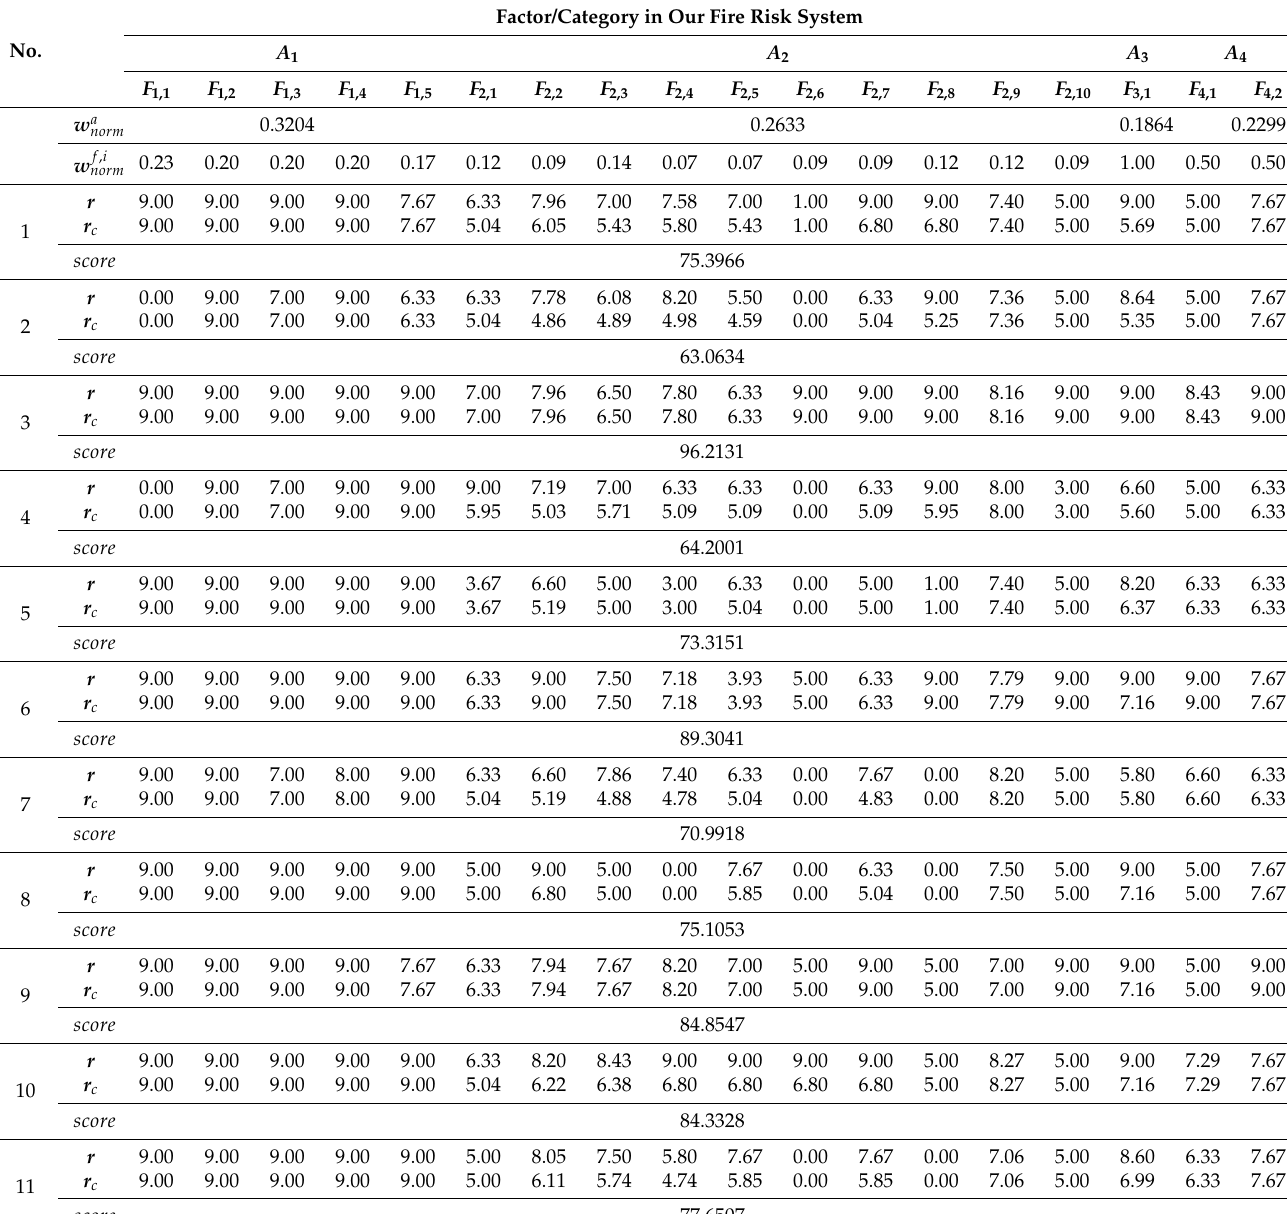
Table 6. The final weights and the revised scores of the categories and factors for the 11